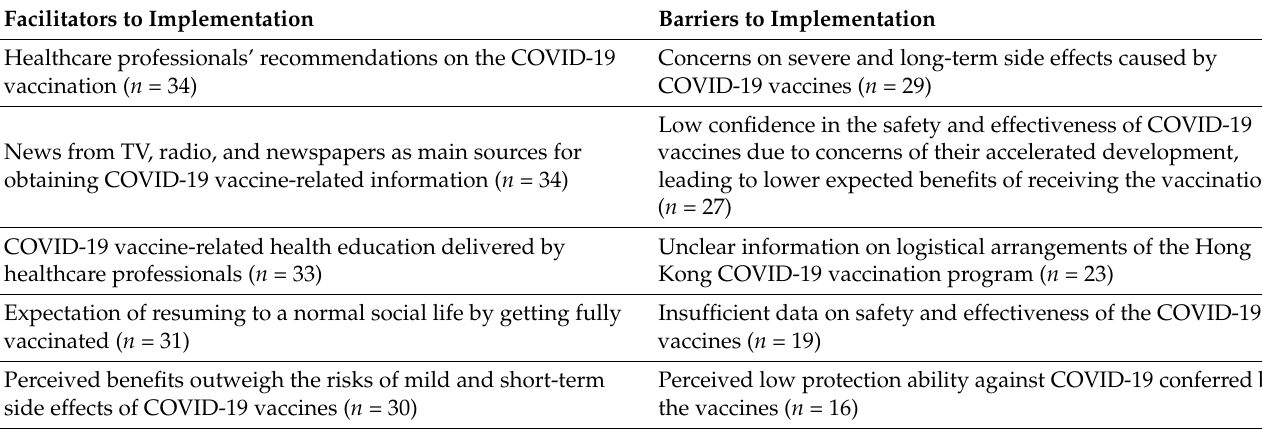
Table 4. Top five commonly discussed facilitators and barriers to implementation among all partici- pants ( n =